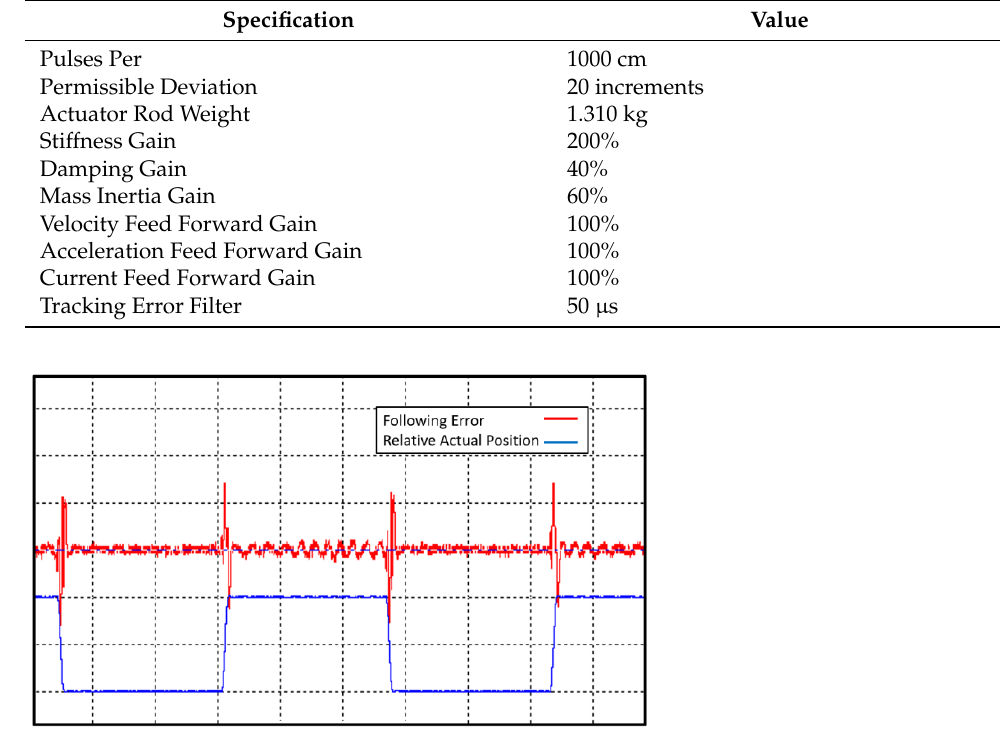
Table 3. PID Loop Relevant Parameters.